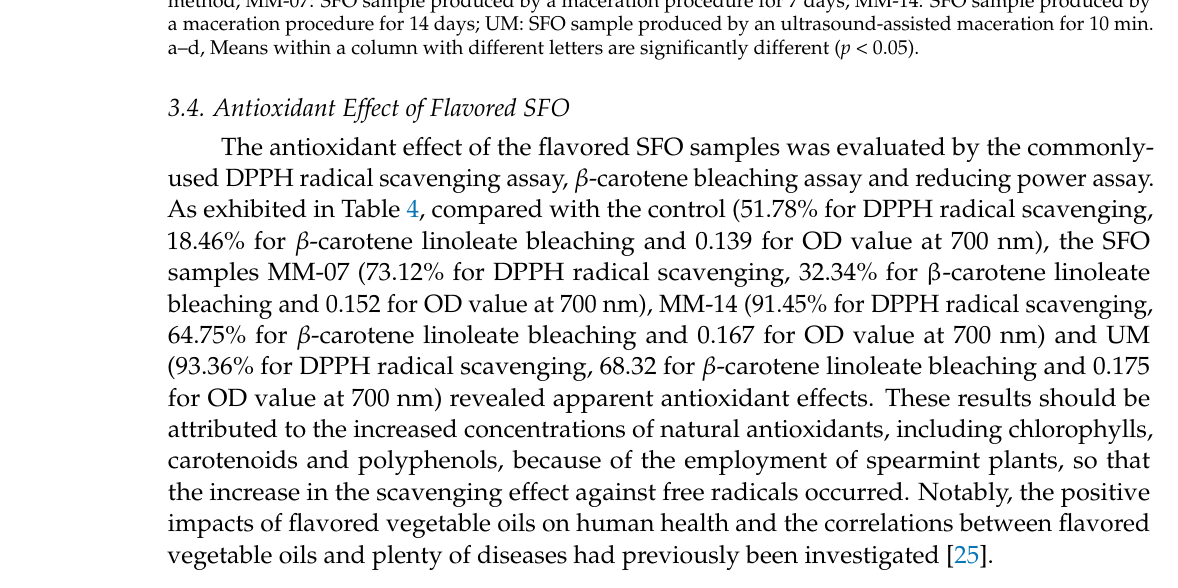
Table 4. The antioxidant effect of SFO samples A